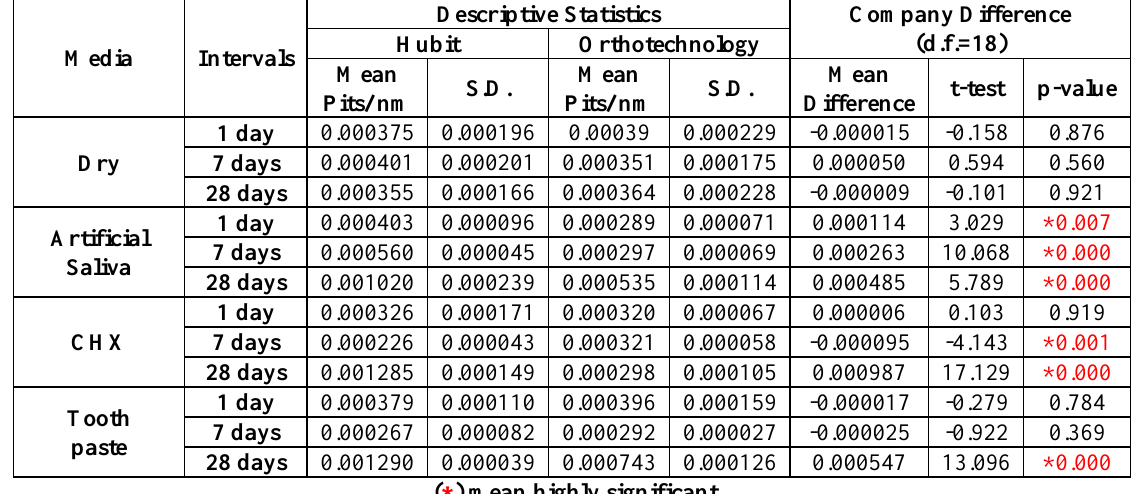
Table 1: The Effect of Coating Material Difference for Each Wire Immersed in Specific Media for Different Intervals.